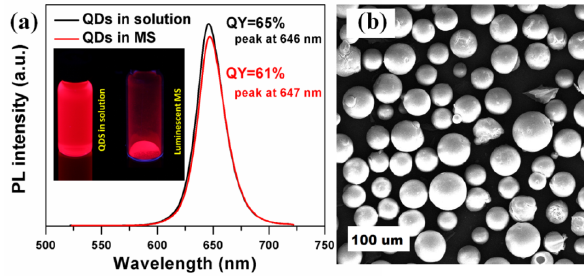
Figure 4: (a) PL spectra of QDs in solution and LMS. (Inset: Pho- tographs of the as-prepared QDs in solution and in microspheres) (b) Image of LMS by SEM. PL: photoluminescence; ODs: quantum dots; LMS: luminescent